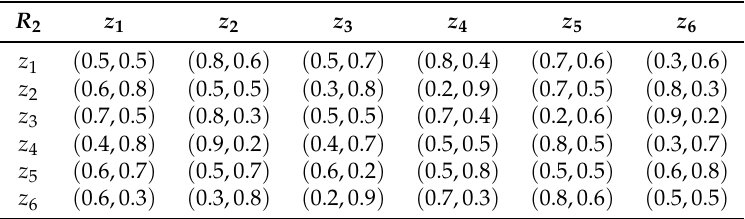
Table 2. PFPR of the first stock